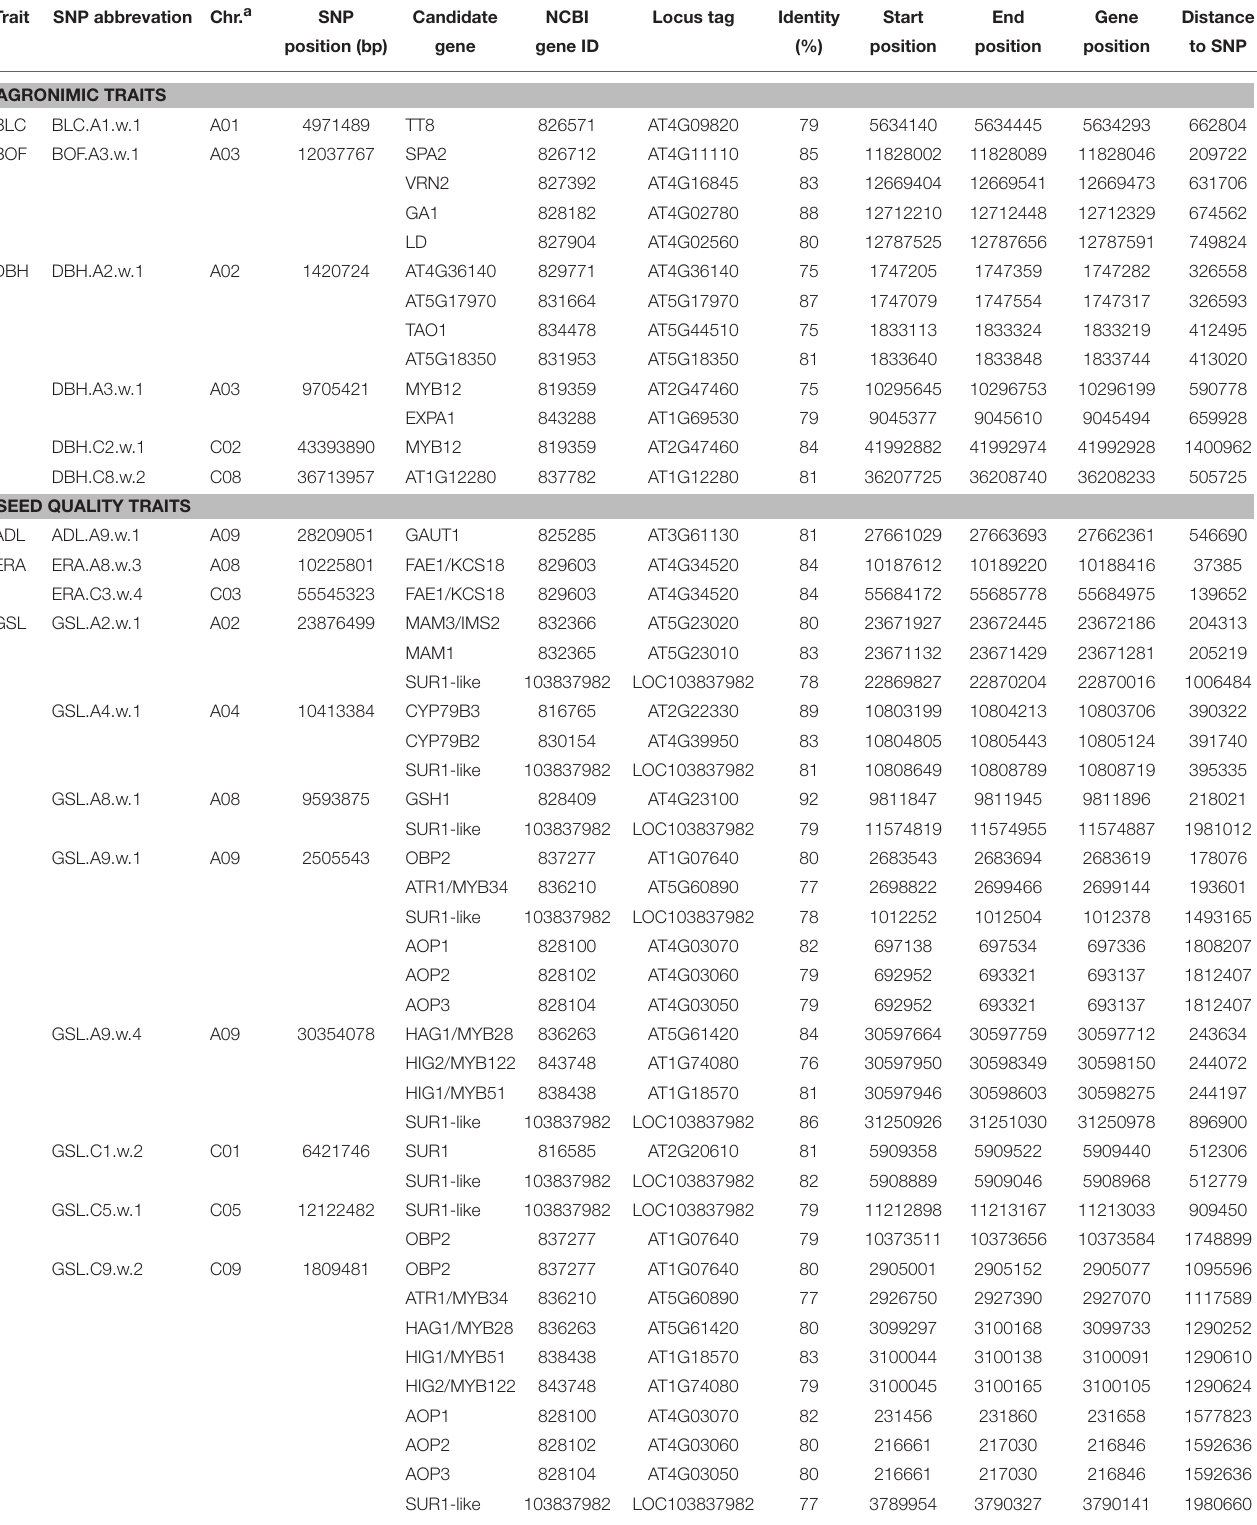
TABLE 5 | BLAST search results for pre-selected candidate genes for the single nucleotide polymorphism (SNP)-trait associations with P < 1.28e-05 (Bonferroni correction of α = 0.05) within a distance of 2.5 Mbp around the SNP-trait associations across the 214 inbreds of the winter trial. Trait SNP abbrevation Chr.